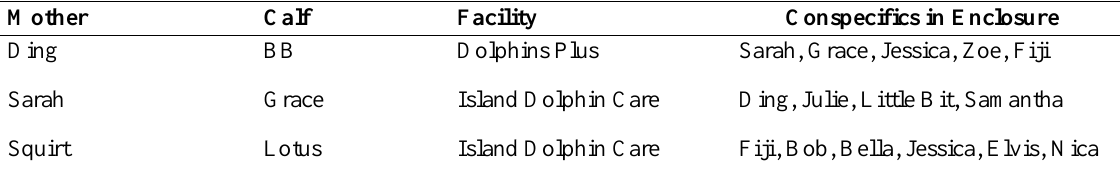
Lotus Island Dolphin